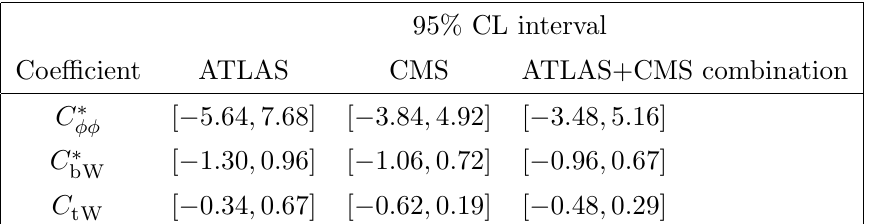
, C (cid:3) , and C at 95% CL. The limit on tW (cid:30)(cid:30) bW